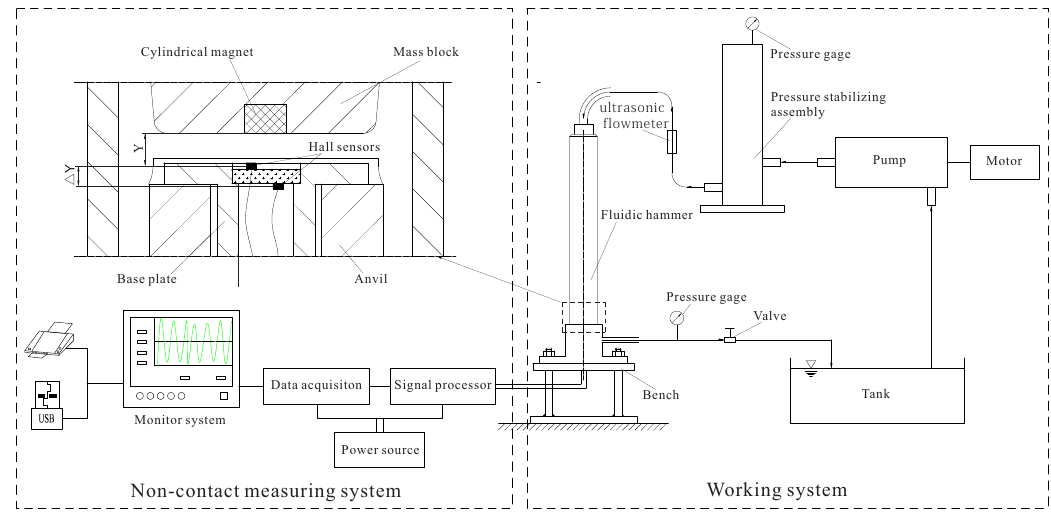
Figure 11. Schematic of the experimental system.